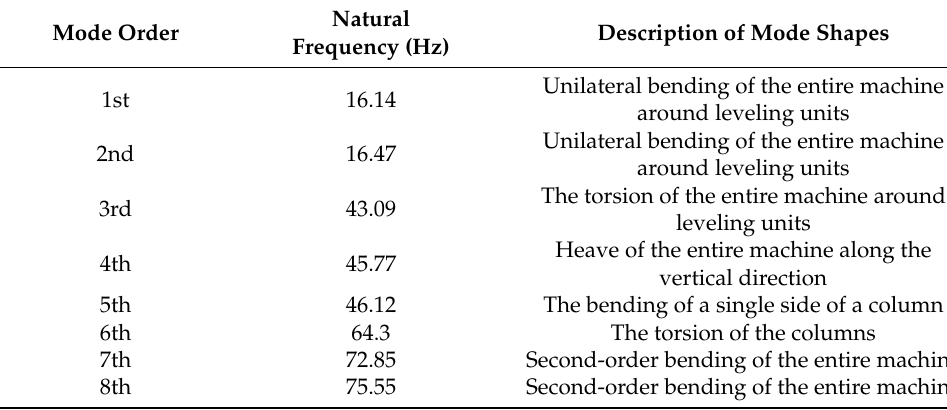
Table 3. Modal test results of the tracking frame.